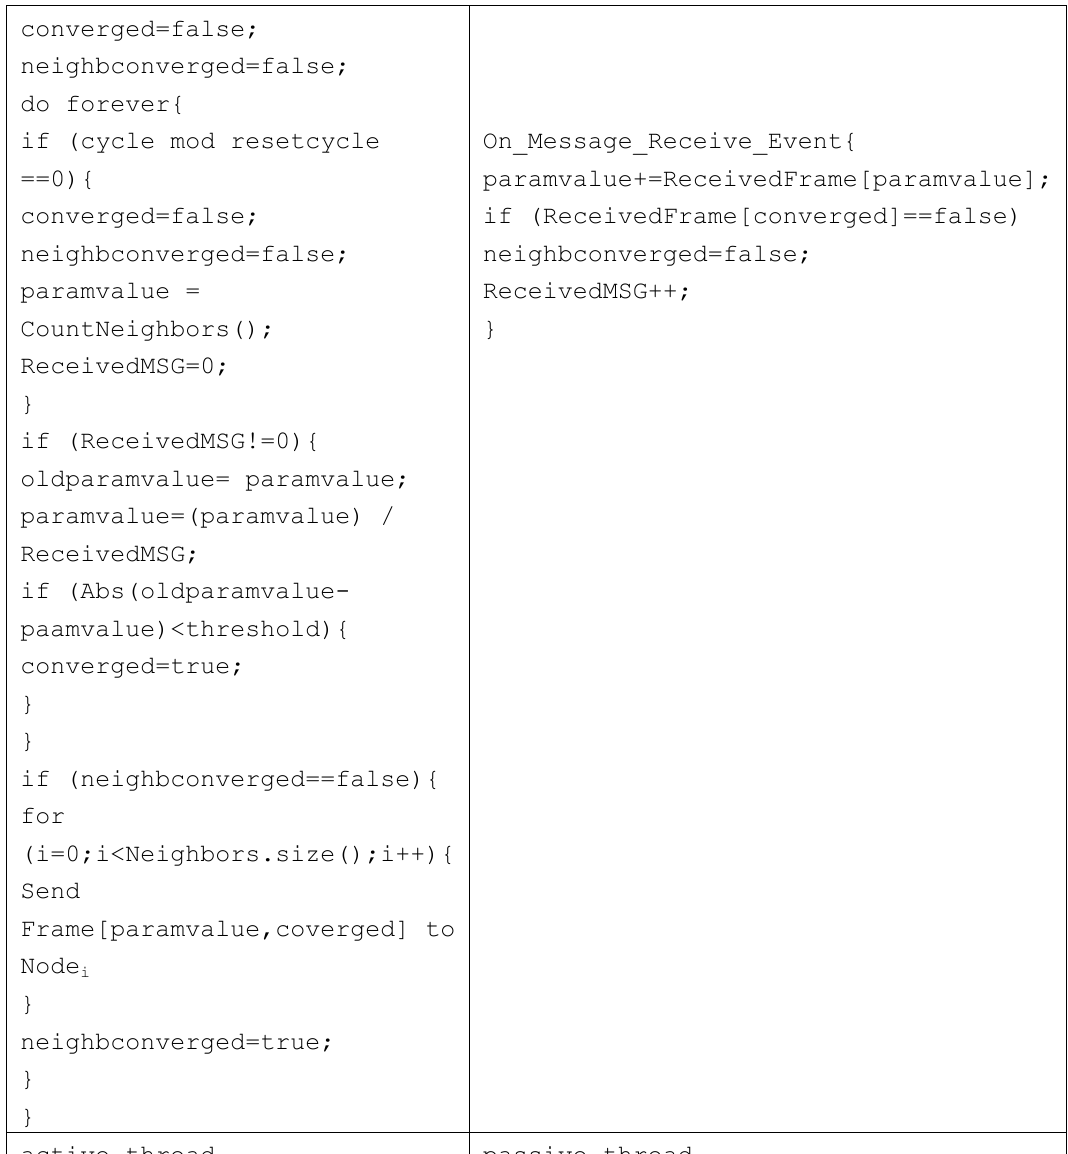
Table 1. Averaging through